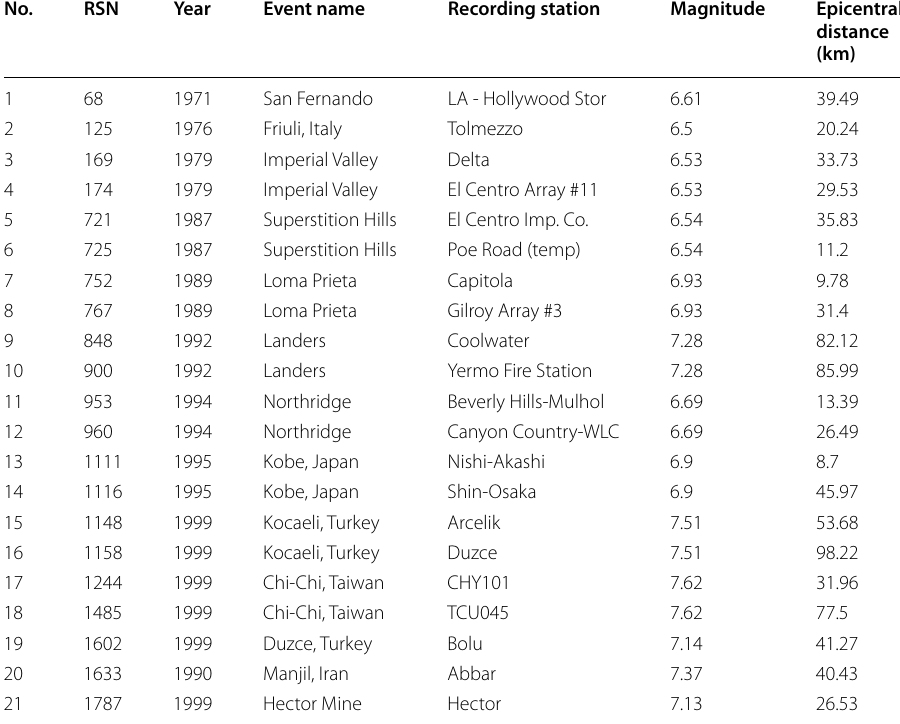
Table 1 Summary of the information regarding the selected earthquake records No.